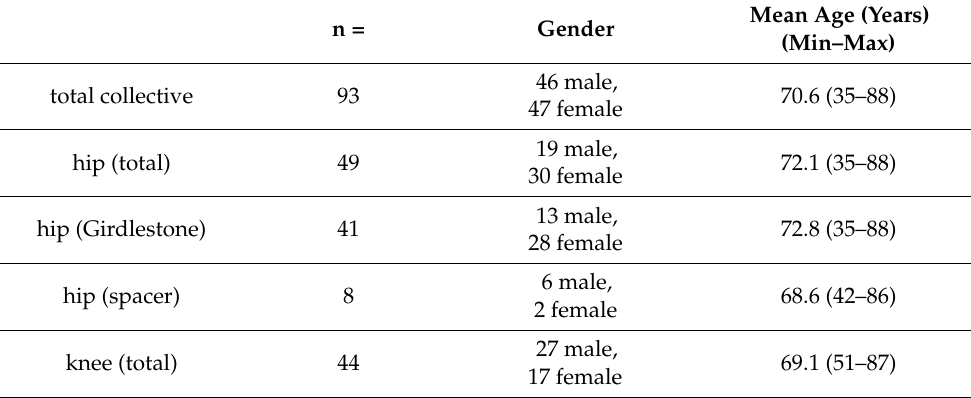
Table 1. Demographic data of all included